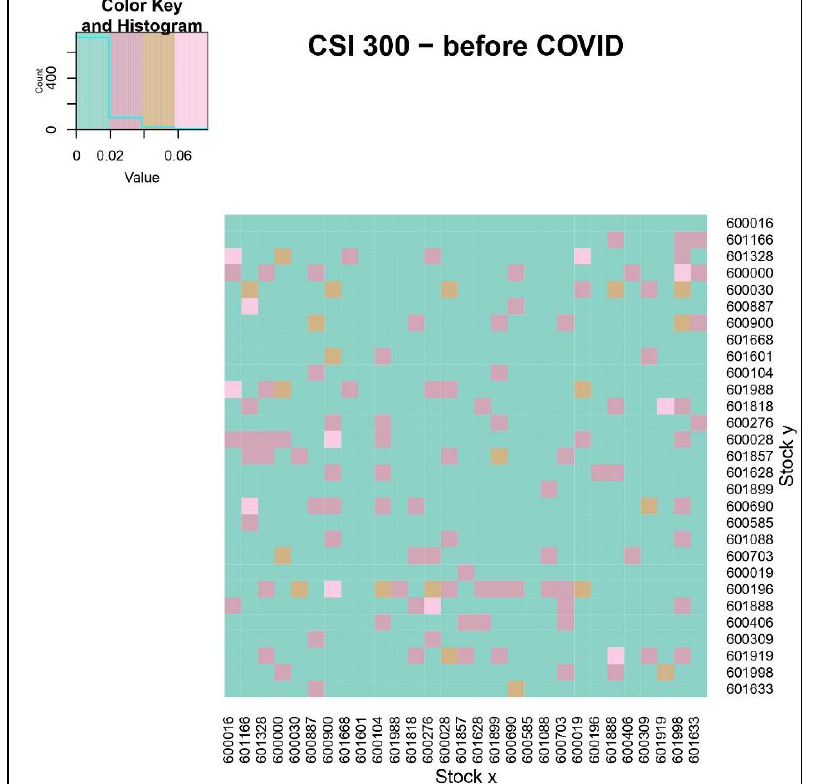
Figure 3. The information flow (effective transfer entropy) from stock y to stock x, for the top companies (by market capitalization) in the CSI market, before the COVID-19 outbreak